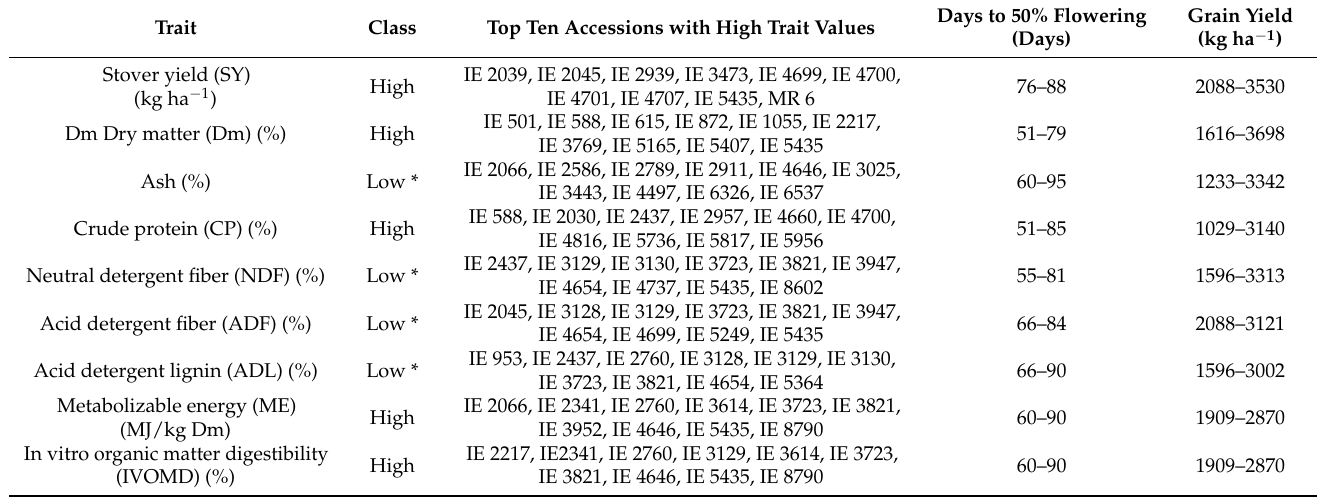
Table 7. Top 10 finger millet accessions with the desirable value of each forage quality